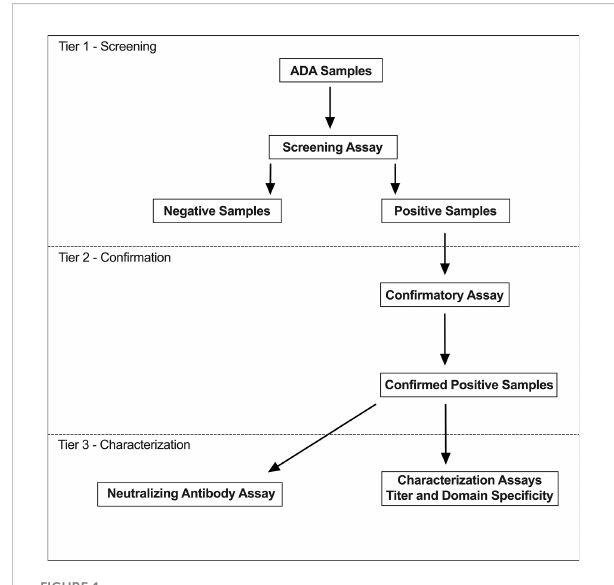
FIGURE 1 Tiered anti-drug antibody sample analysis